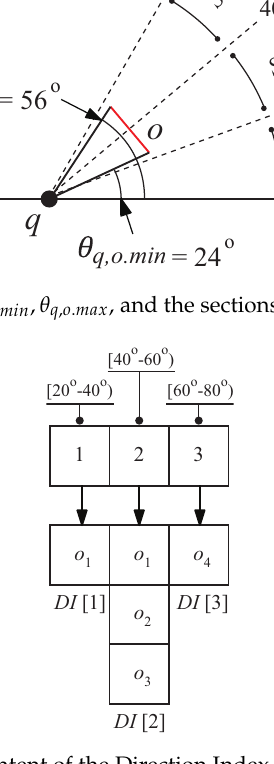
Figure 19. The content of the Direction Index ( DI ) for Figure